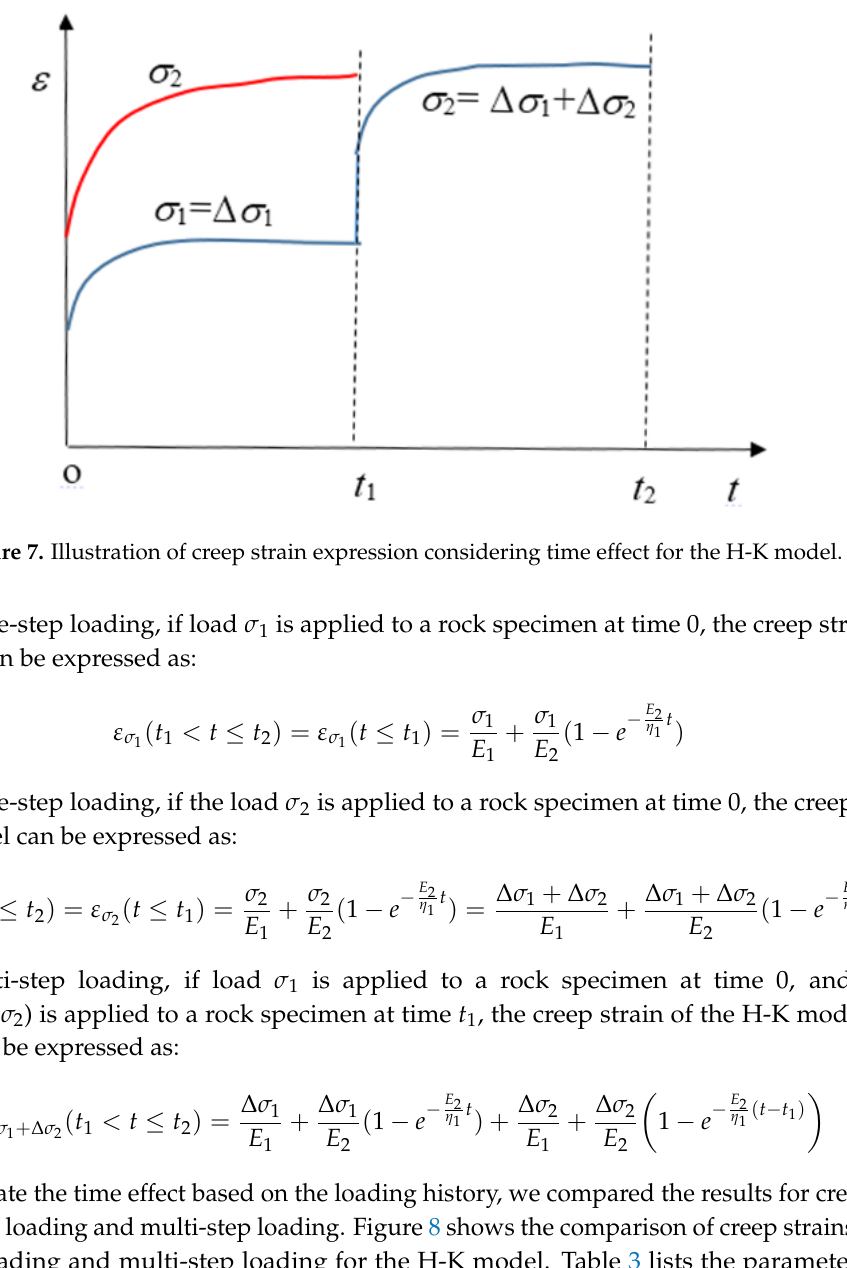
Figure 8. Comparison of creep strains between single-step loading and multi-step loading for H-K model.